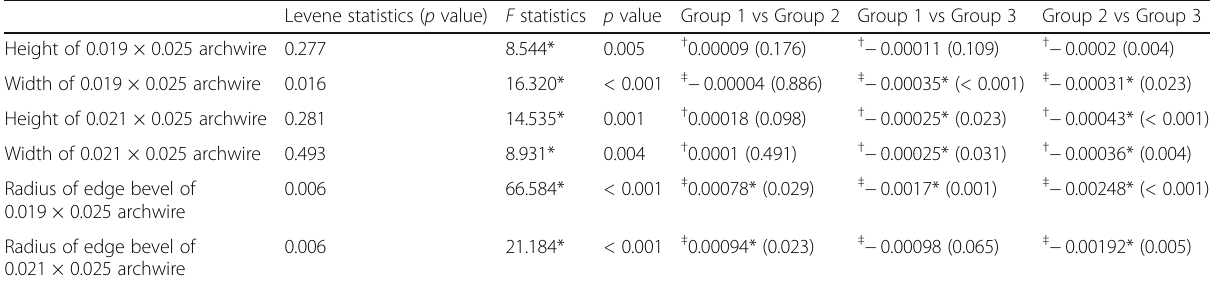
Table 5 Results of one-way ANOVA, divided by each group, comparing slot measurements for different archwires